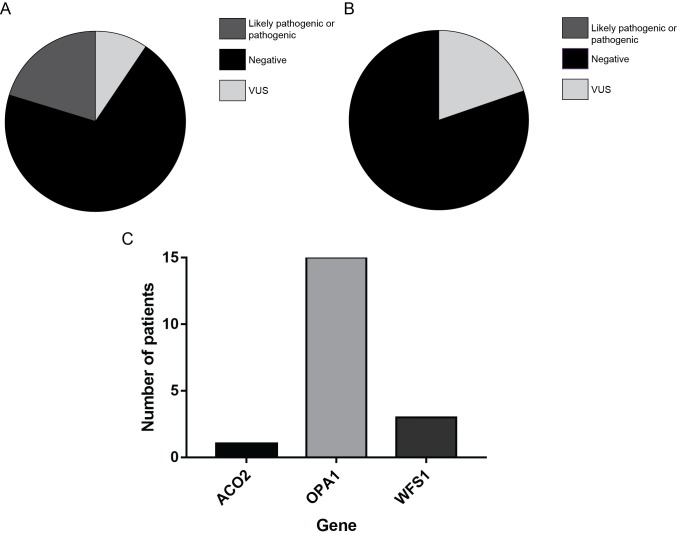
Variant identification and classification of ninety-seven patients sent for NGS.(A) PEO/Optic Atrophy nuclear panel results (N = 94). (B) mtDNA results (N = 81). (C) Frequency of patients with a definitive positive molecular diagnosis with causative nuclear gene.